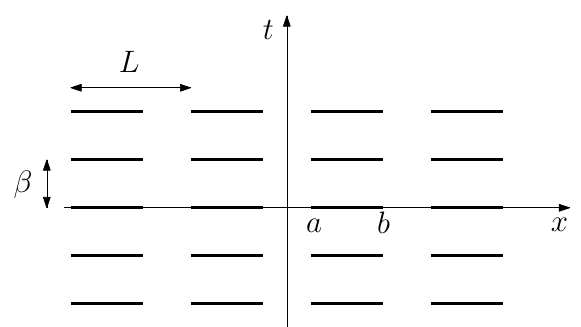
Figure 1. The region V (cid:3) when V is the interval ( a; b